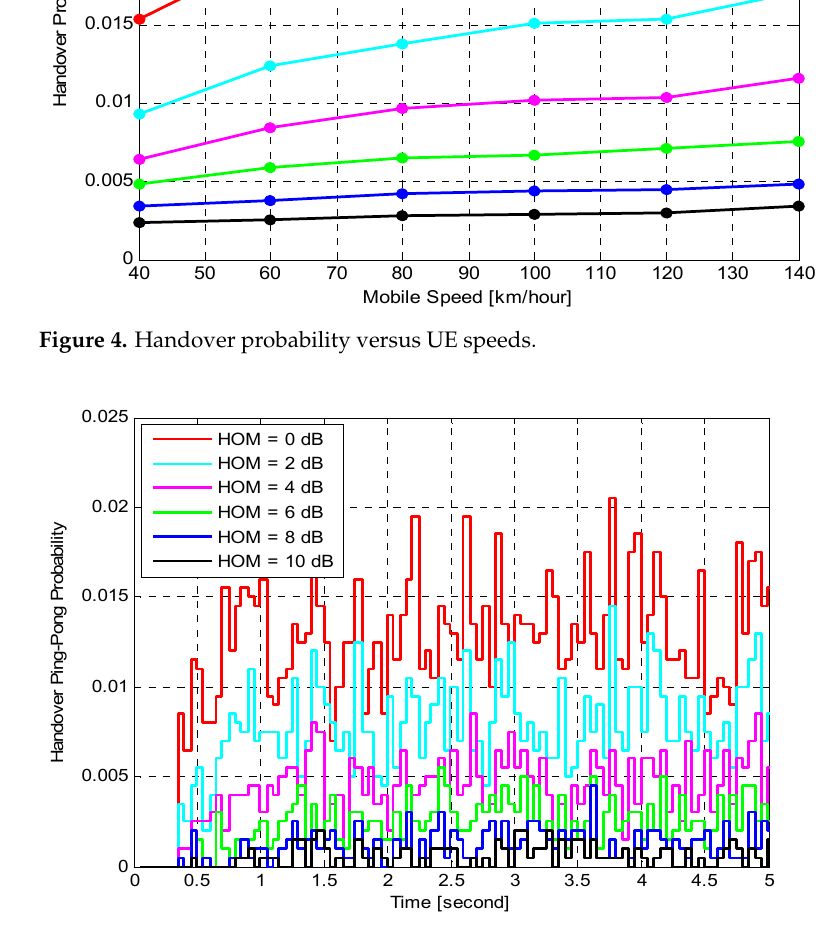
Figure 6. UE outage probability versus HOM level.